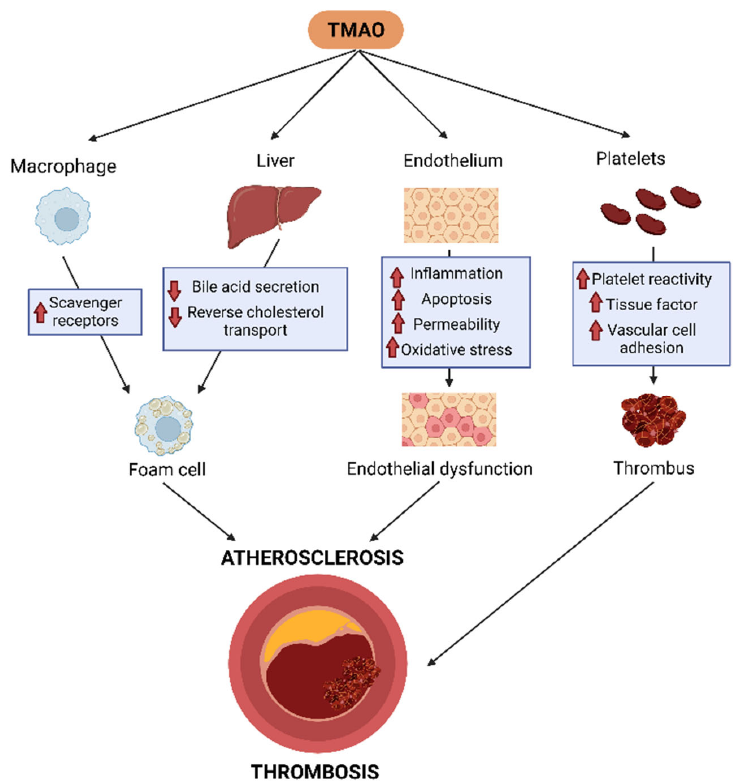
Figure 2. TMAO enhances proatherogenic and prothrombotic mechanisms. TMAO promotes macrophage foam cell formation, impairs liver cholesterol metabolism, affects reverse cholesterol transport, and induces endothelial dysfunction and platelet aggregation by a variety of mechanisms. TMAO: Trimethylamine ‐ N ‐ oxide.